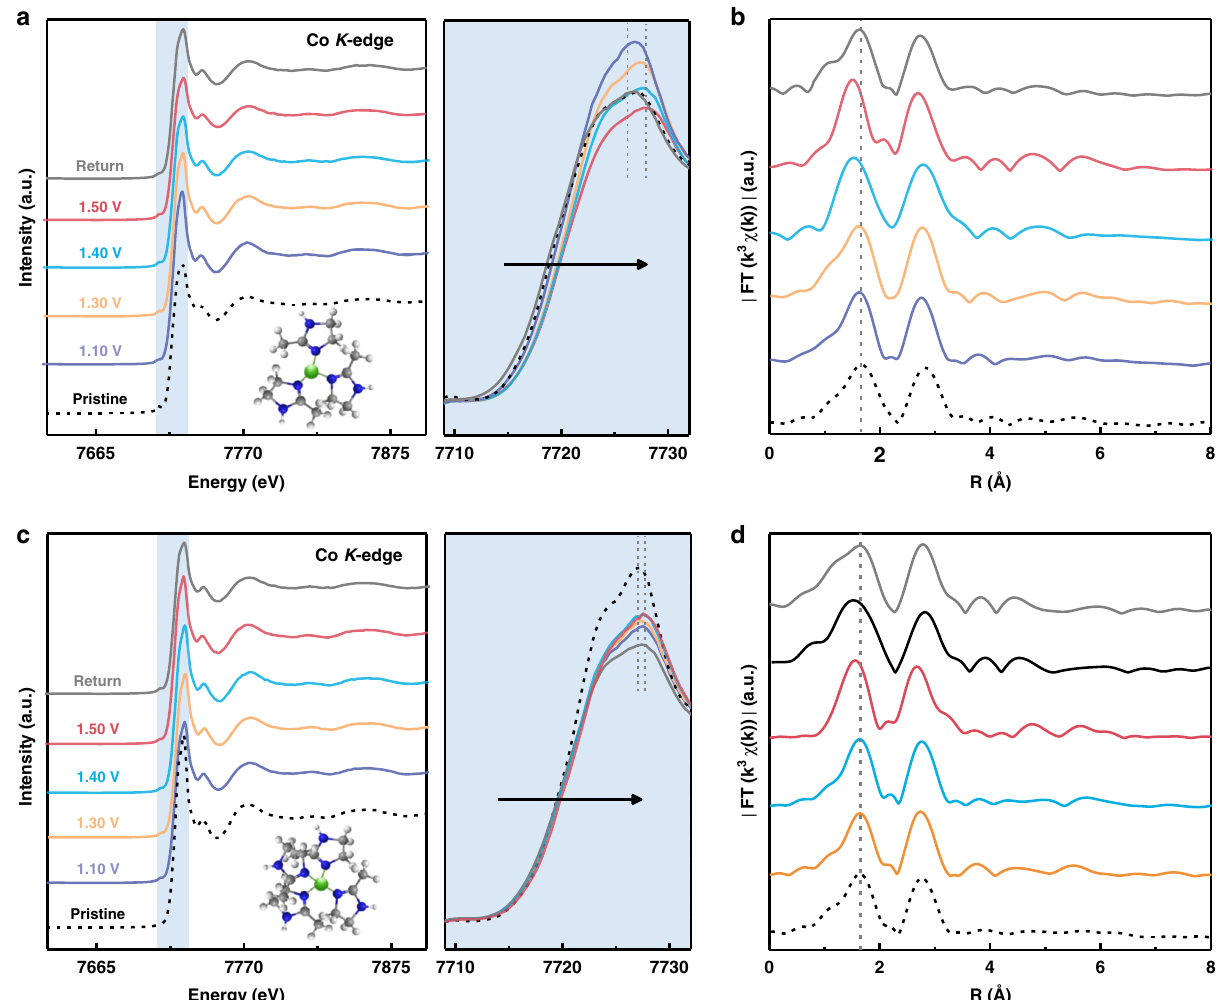
Fig. 5 X-ray absorption spectroscopic analysis. Co K -edge ( a ) XANES spectra and ( b ) EXAFS in R-space of as-prepared BHZ-48 collected during potentiostatic OER experiments at various potentials. Co K -edge ( c ) XANES spectra and ( d ) EXAFS in R-space of as-prepared BHZ-96 collected during potentiostatic OER experiments at various